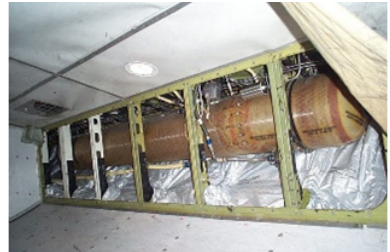
Figure 2. Aircraft potable water tank.